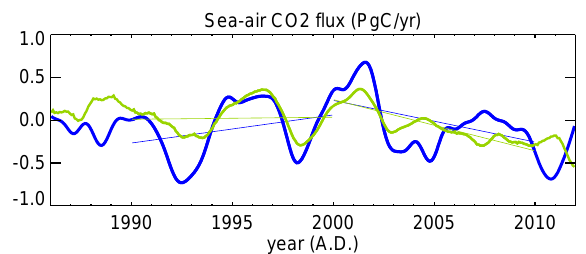
Fig. 8. Interannual anomalies of the total ocean CO 2 flux estimated Figure 8. Interannual anomalies of the total ocean CO 2 flux esti- by run SFC (blue) and by the ocean process model run by Buiten- mated by run SFC (blue) and by the ocean process model run by huis et al. (2010) (olive). Temporal filter and sign convention as in Buitenhuis et al. (2010) (olive). Temporal filter and sign conven- Fig. 3. Linear fits of these results over the 1990–1999 and 2000– tions as in Fig. 3. Linear fits of these results over the 1990–1999 2009 periods are overplotted as thin lines. and 2000–2009 periods are overplotted as thin